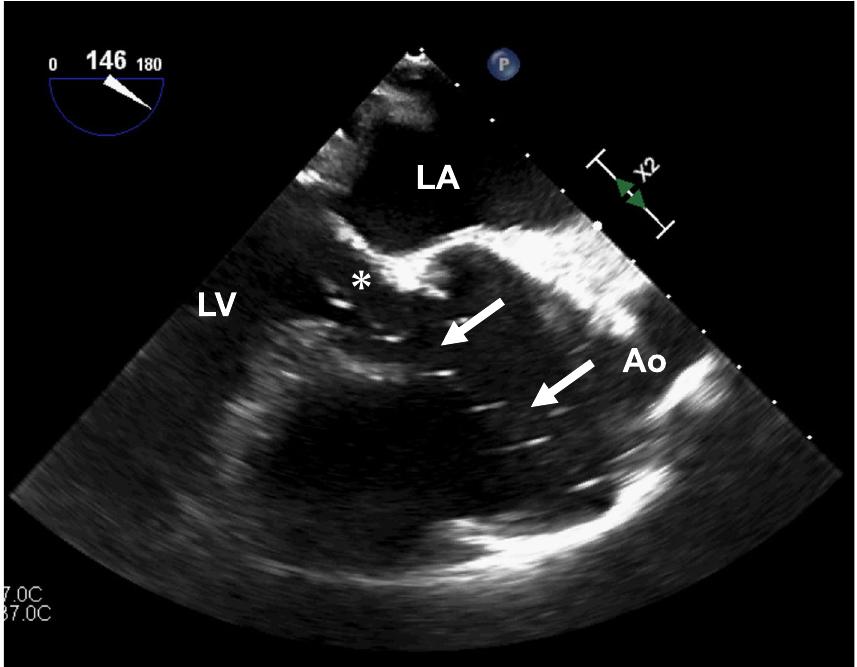
Fig. 2 Echocardiographic mid-esophageal aortic valve long-axis view. The tip of the left ventricular vent (white arrow) was detected in the aortic